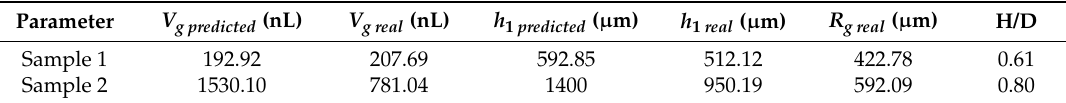
Table 2. The experimental results of the two samples.